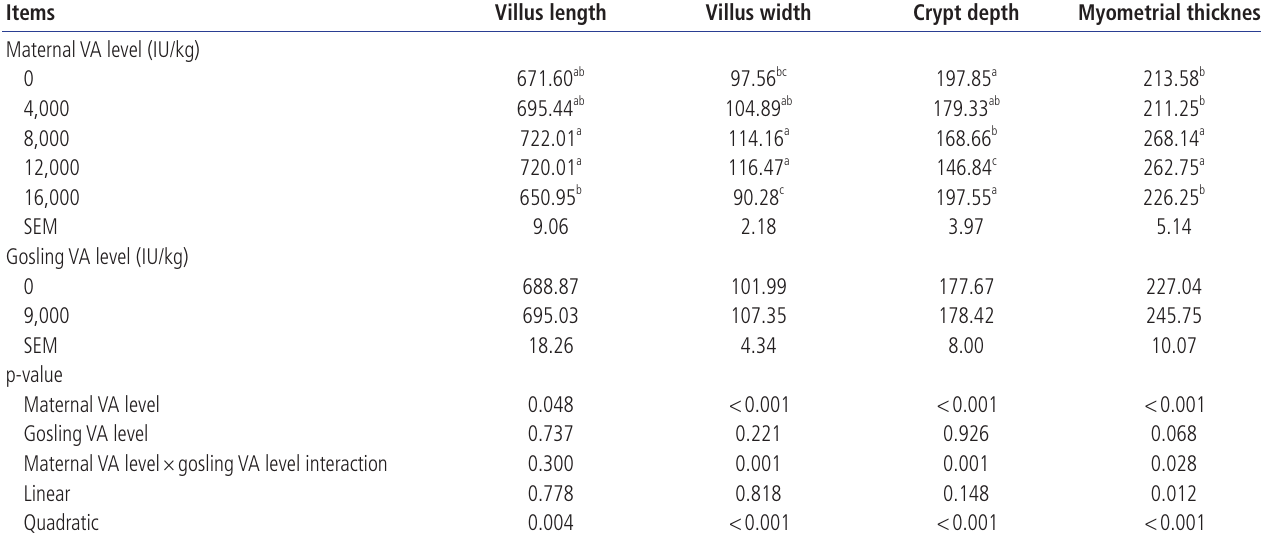
Table 3. Effects of different vitamin A levels in maternal and offspring diets on jejunum histomorphology of goslings (μm) Items Villus length Villus width Crypt depth Myometrial thickness Maternal VA level (IU/kg)